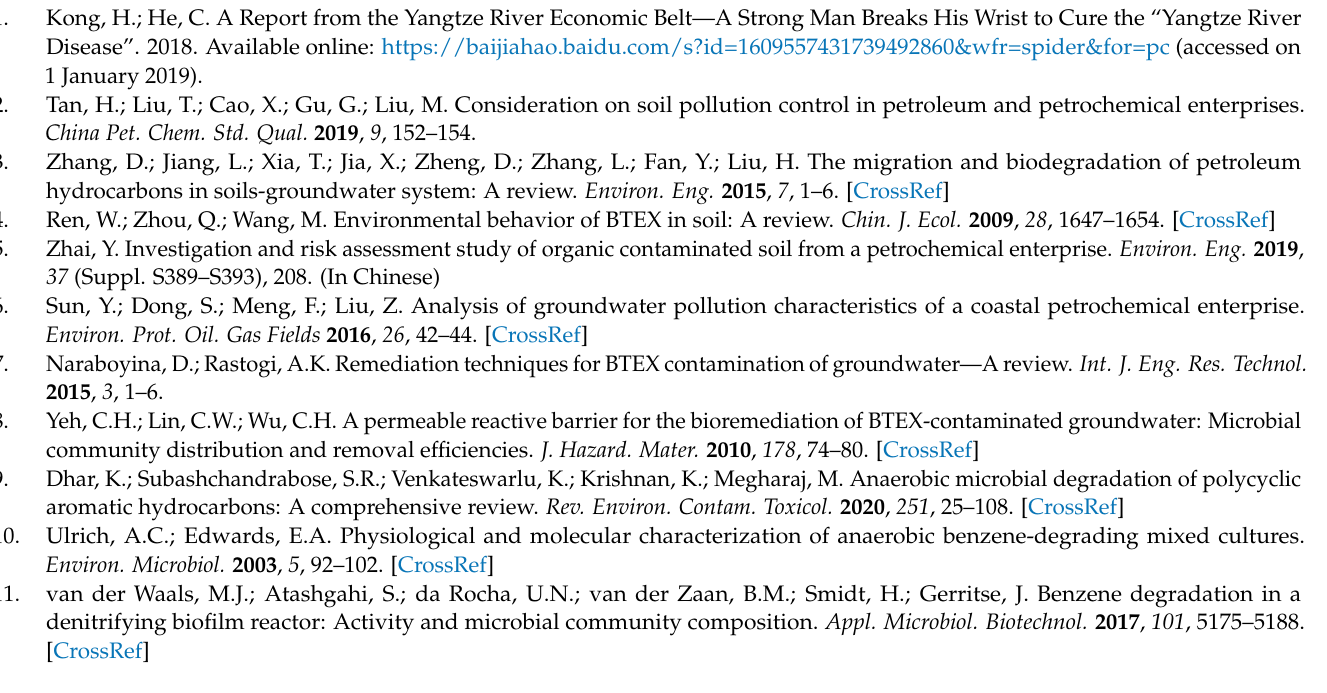
lution; Table S2. The components of mineral solution; Figure S1. COG Functional prediction at L2 level for the samples. (S indicates soil, GW indicates groundwater); Figure S2. Pathway of ethyl- benzene degradation (KEGG, 2022); Figure S3. The changes of BTEX concentrations over time in different